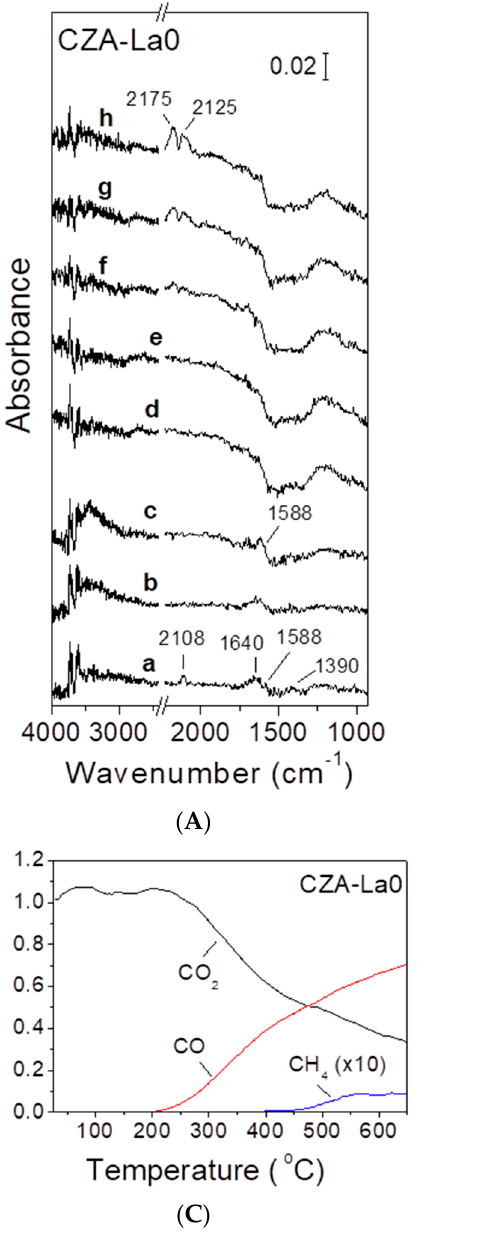
Figure 5. In situ DRIFT spectra obtained over ( A ) the CZA-La0 and ( B ) the CZA-La50 catalyst following interaction with a reaction mixture consisting of 1% CO 2 and 9% H 2 (in He) at (a) 25 °C and stepwise heating at: (b) 100 °C; (c) 150 °C; (d) 200 °C; (e) 250 °C; (f) 300 °C; (g) 350 °C; (h) 400 °C. The transient-MS spectra obtained over the CZA-La0 and CZA-La50 catalyst under the same conditions are shown in ( C ) and ( D ), respectively.